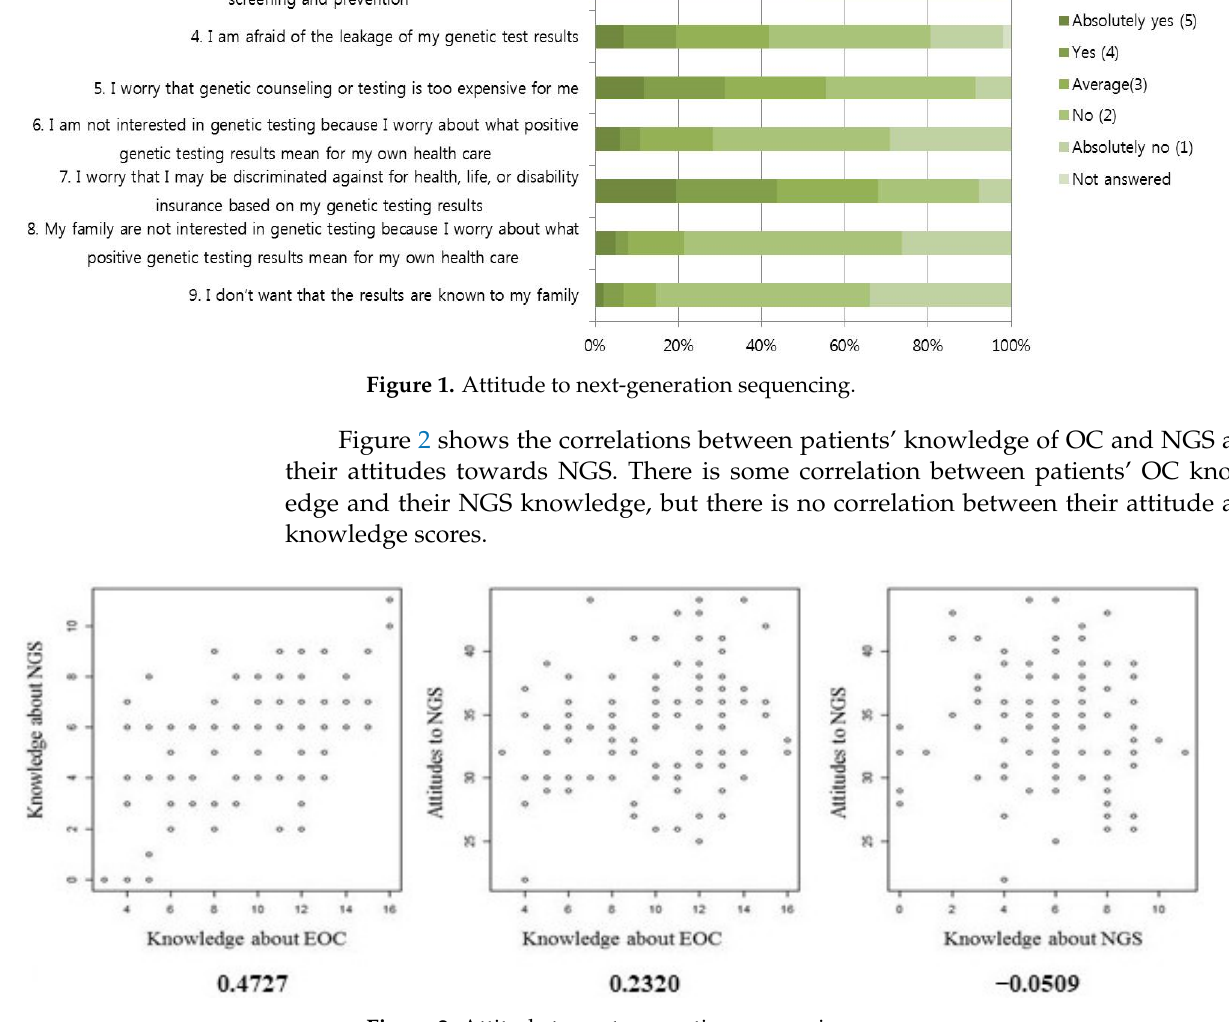
Figure 2. Attitude to next-generation